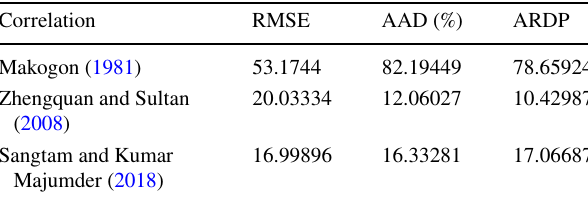
Table 8 Statistical errors for temperature range: 260 ≤ T ≤ 320 K Correlation RMSE AAD (%)